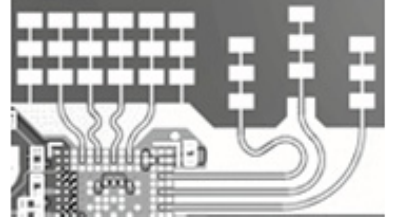
Figure 4. Antenna design [6–11].